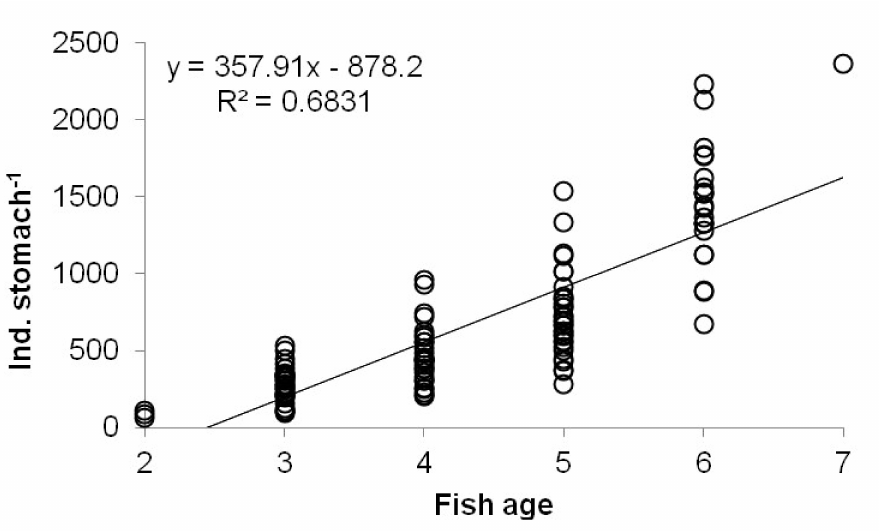
Figure 4. Significant Spearman correlations between fish age and abundance of D. pulex in fish stomach ( R = 0.86, p < 0.0001).